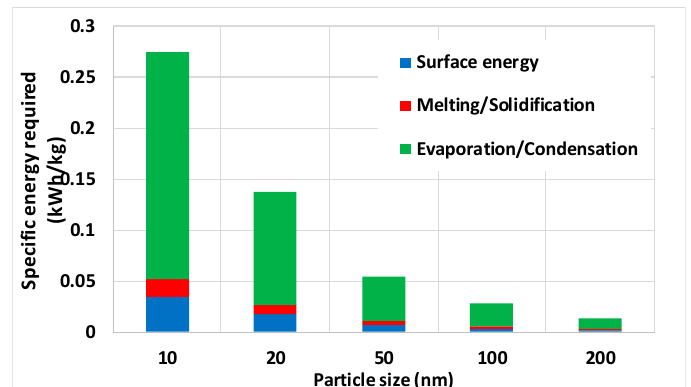
Figure 15. Specified electricity consumption (SEC) for copper NP production considering surface energy and losses due to melting/solidification and evaporation/condensation.